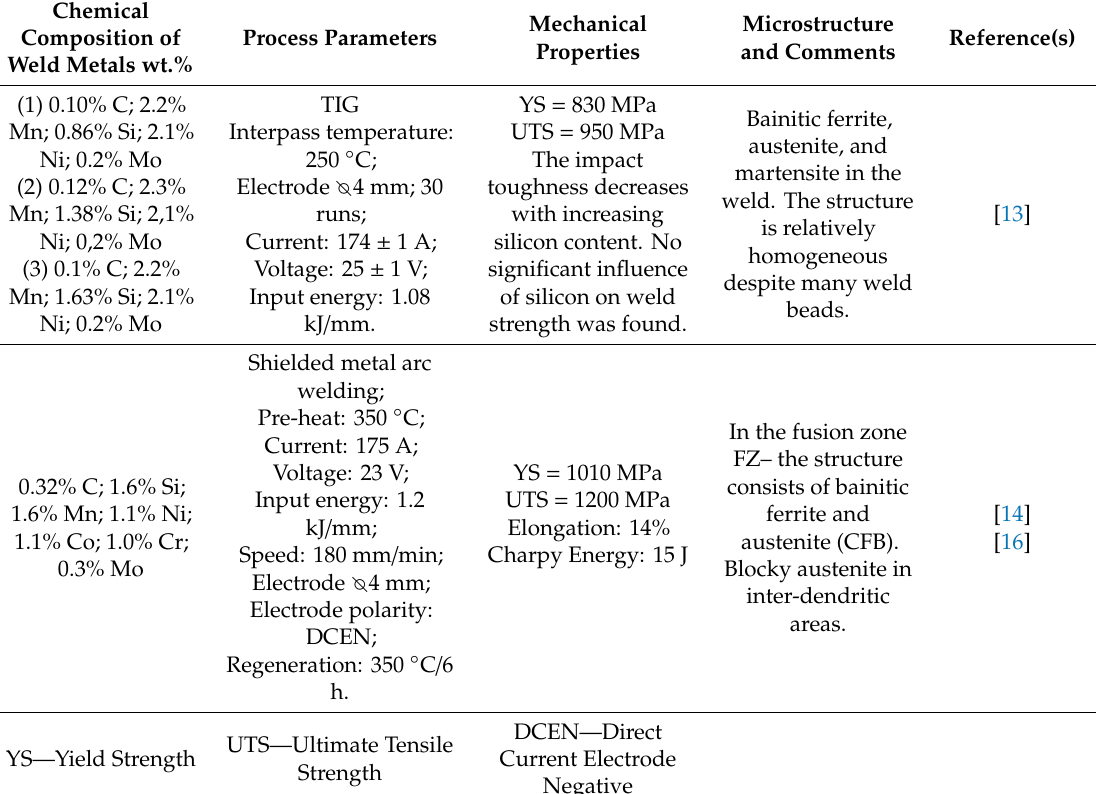
Table 1. Review of weld metals that allow a carbide-free bainite (CFB) structure to be obtained.